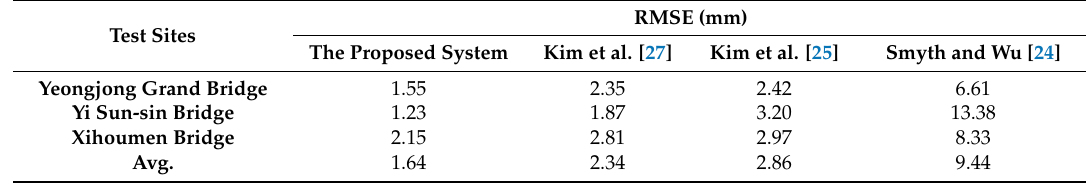
Table 3. Comparison of displacement estimation performances through field bridge